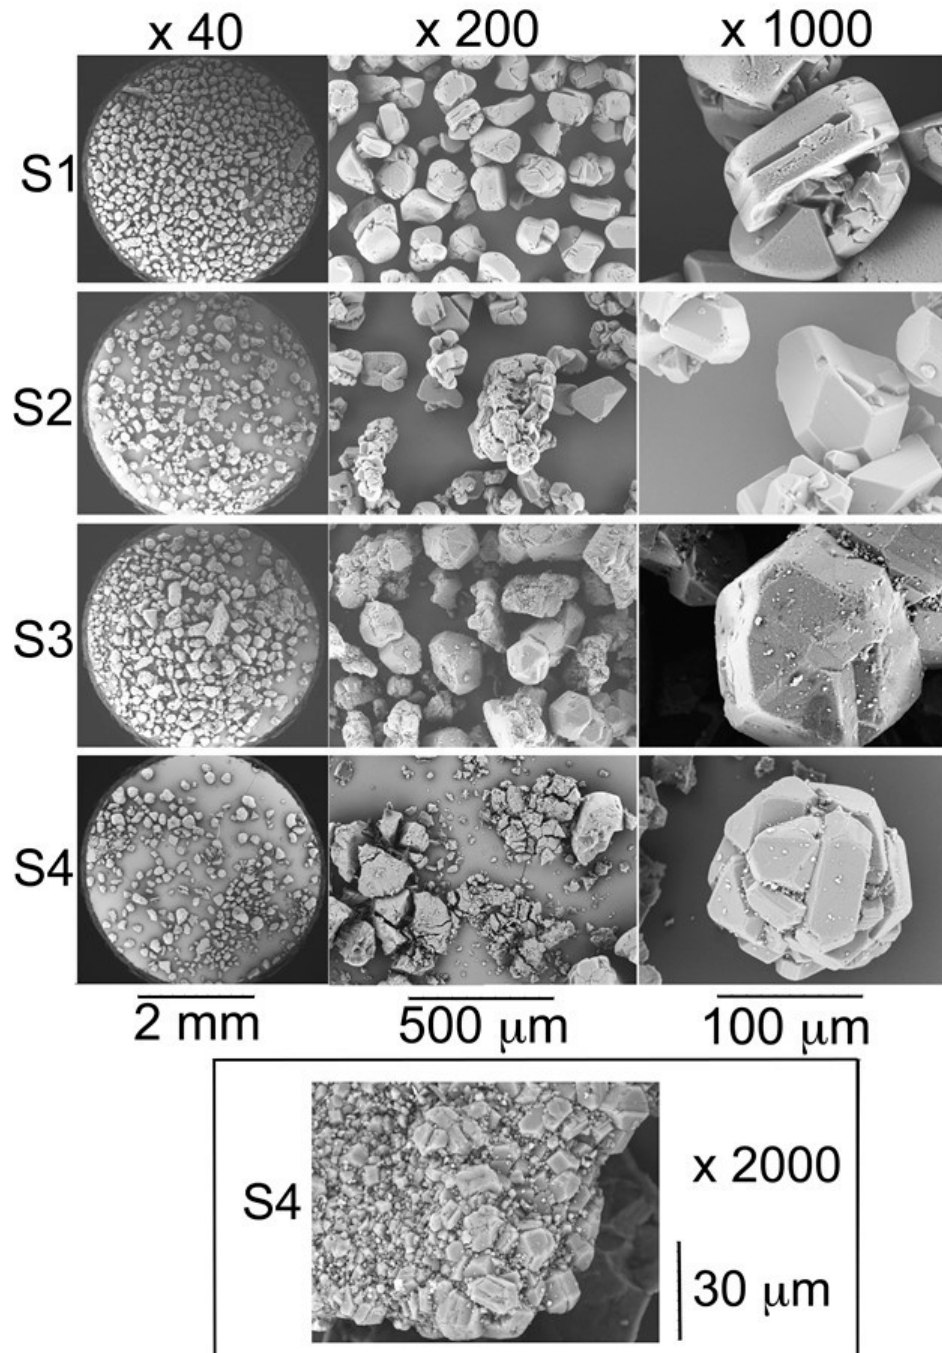
Figure 1. Scanning electron microscopy photographs of crystalline C 60 powders of samples S1, S2, S3, and S4 with different magnifications. The inset shows the photograph of an aggregate of C 60 crystals found in sample S4.